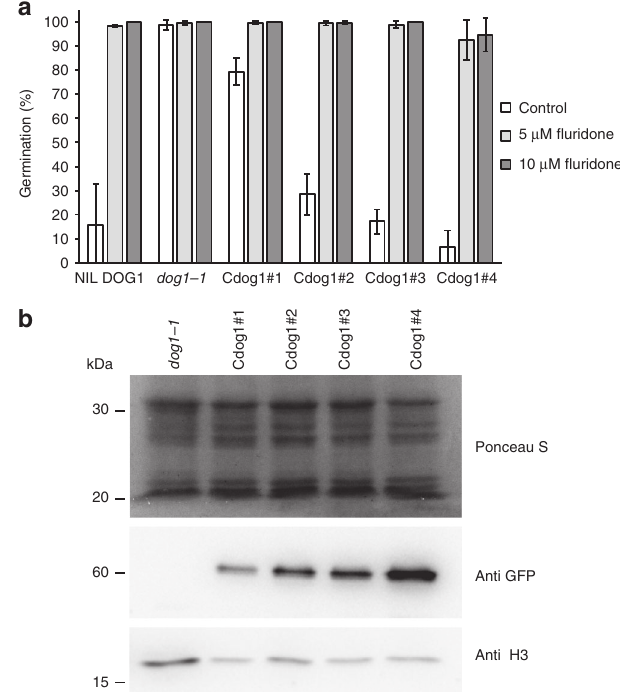
Fig. 1 The YFP-DOG1 transgene complements the dog1-1 non-dormant phenotype. a Germination of freshly harvested seeds on 0.05% ethanol (control) or on 0.05% ethanol plus the indicated concentrations of fl uridone. Radicle emergence was scored 7 days after sowing. Shown are averages ± s.d. of three independent batches of seeds for each genotype. b YFP-DOG1 protein accumulation in the complementation lines. ( top ) Ponceau S staining. DOG1 protein was detected using GFP antibody. After stripping, the same membrane was blotted with H3 antibody as loading control. Cdog1#1-4 represent four independent dog1-1 transformants containing the YFP-DOG1